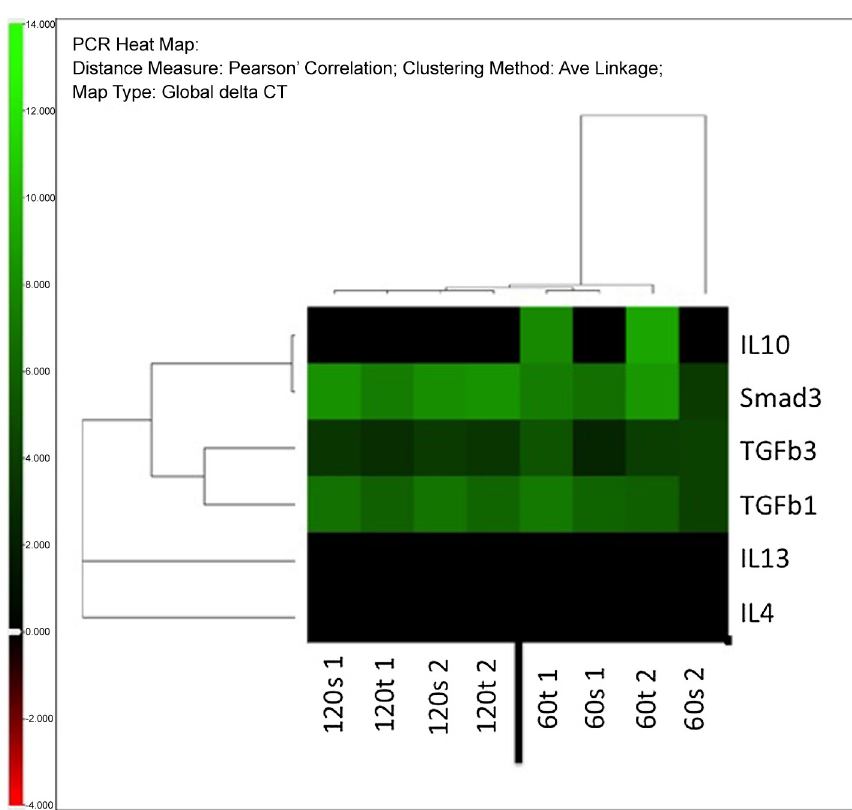
Fig 16. Results of quantitative real time PCR for IL10, IL4, IL13, TGFb-1, TGFb-3 and Smad3 given in delta Ct (Ct gene — Ct housekeeping gene) for each study group and illustrated as heat map (Distance measure: Pearson ’ s Correlation; Clustering Method: Ave Linkage; Map Type: Global delta CT; Ct > 40,000 = not determined). Increasing positive or negative delta CT values are given in brighter green or red colors, respectively. Black indicates that either the gene is not expressed or is below the limit of detection.